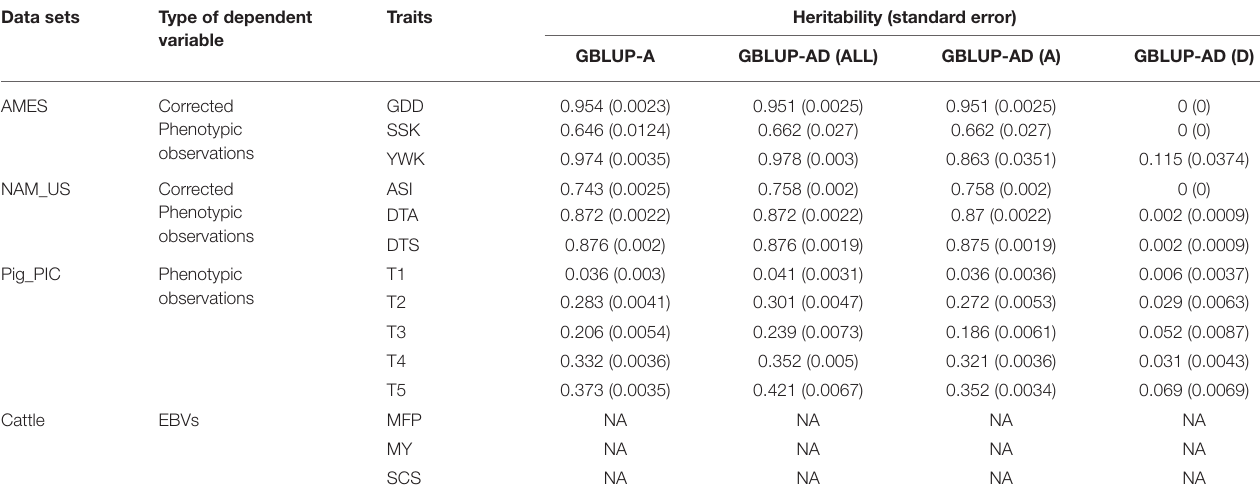
TABLE 1 | Heritability estimation in four